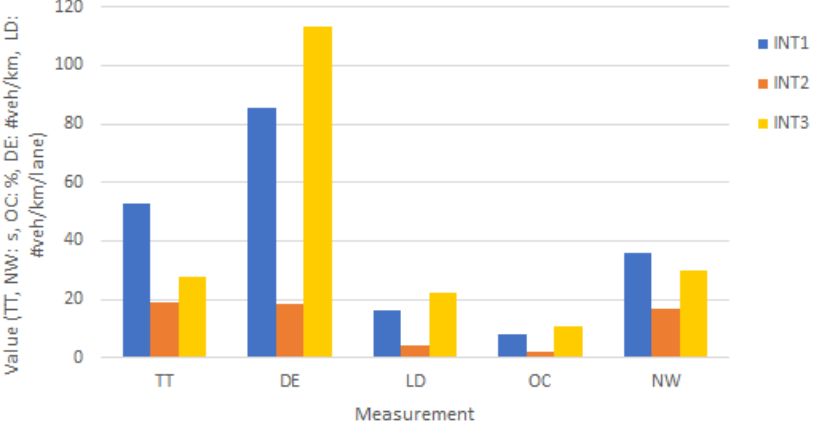
Figure 9. The comparison of simulated intersections (TT: travel time, DE: density, LD: lane density, OC: occupancy, NW: normalized waiting